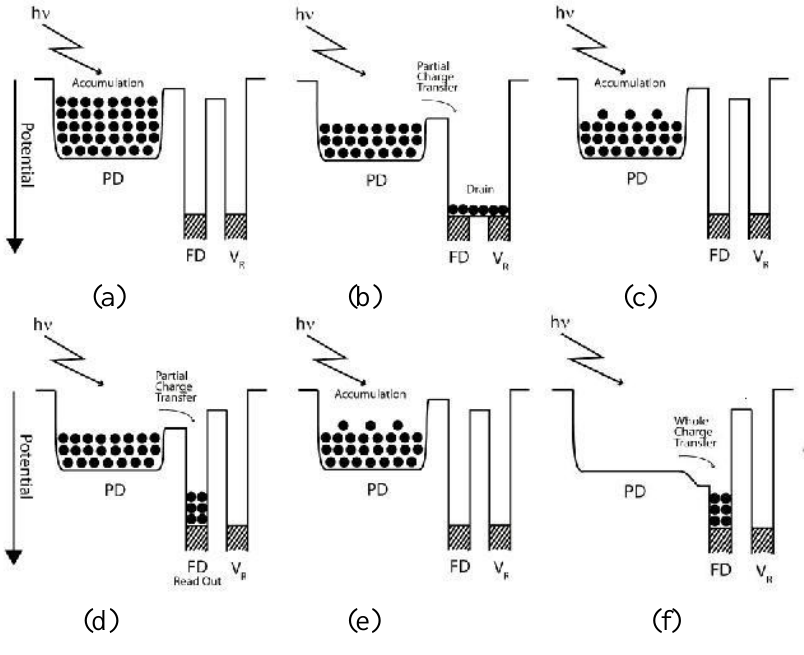
Figure 3. The principle of Partial Charge